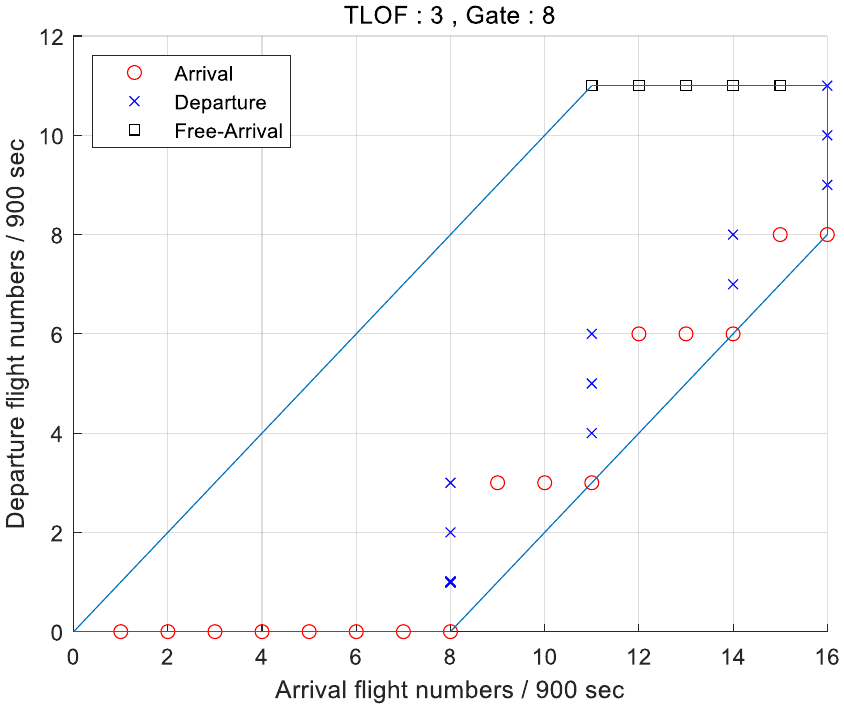
Figure 35. Capacity of a pier topology for Gimpo Airport’s expanded parking lot space that complies with the FAA’s new regulations.